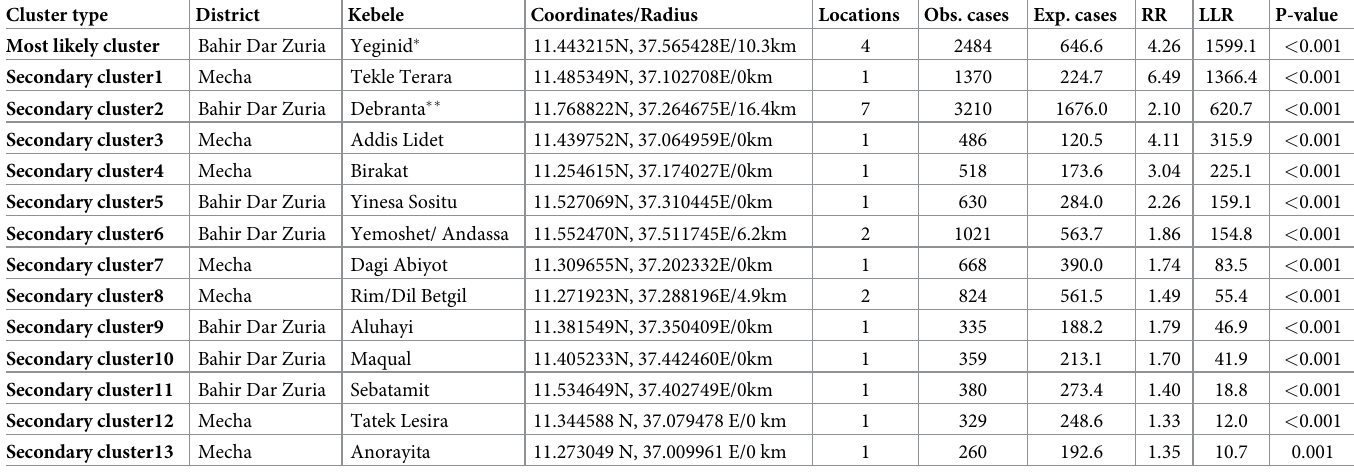
Table 3. Most likely and secondary clusters of malaria cases in Bahir Dar Zuria and Mecha districts between epi week 37/2013 and 38/2018. Cluster type District